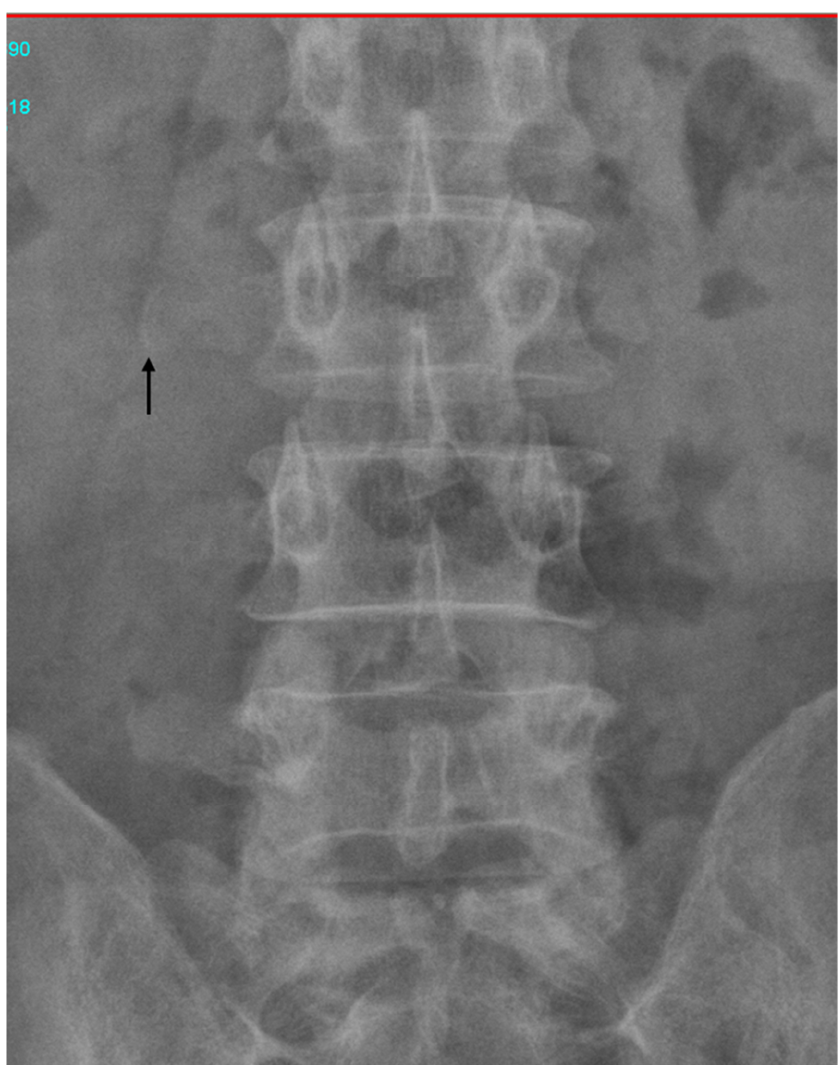
Figure 3. Abdominal radiographs, which revealed that the needle was on the right side of the third lumbar spine vertebra. The symptoms and signs of a retained surgical item include adhesion, foreign body migration, visceral perforation, and abscess formation [1]. These symptoms can occur early in the postoperative period or may develop after months or years [5]. In prior instances, retained surgical suture needles were surgically removed. However, our patient developed symptoms and signs of a retained needle 28 years after his surgery, by which point the needle had migrated to the ampulla of vater, from where it was easily removed through ERCP. Migrated surgical clips, stents, gauze pieces, suture materials, and fragments of t-tubes have all been reported as retained iatrogenic foreign bodies causing CBD obstruction and subsequent sequelae [2]. To our knowledge, this is the first reported case in which a retained surgical needle migrated to the ampulla of vater. Needles comprise 0.06–0.11% of foreign bodies that are retained during surgery [7]. Preventing instances of unintentionally retained surgical materials is a critical problem. A nationwide Brazilian study of retained surgical foreign bodies reported that challenging medical situations, security protocol omission, and inadequate work conditions contributed to retained foreign bodies. Sponges are notoriously overlooked because they are routinely inserted into cavities to expose the operative field. Thus, a preventive protocol could involve the introduction of the use of sponge-holding forceps [8]. In conclusion, CBD obstruction caused by foreign bodies can be safely ameliorated through ERCP without complications noted during